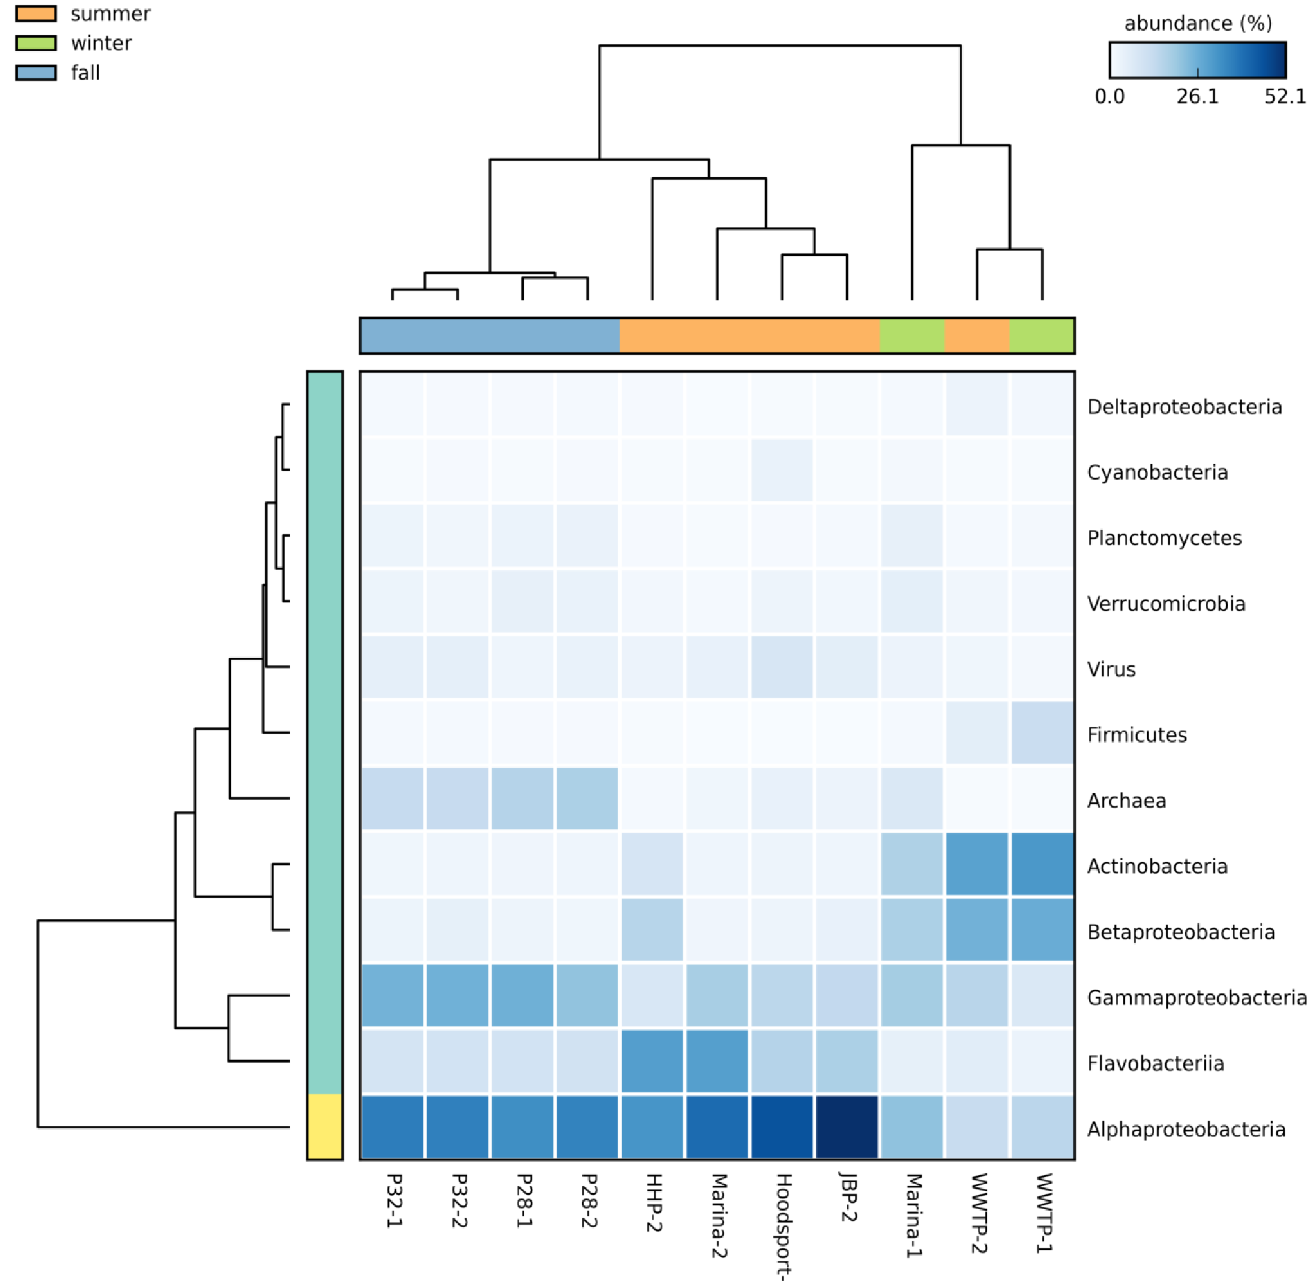
Fig 2. Regional and seasonal community composition differences in Puget Sound showing relative taxonomic abundances for 11 metagenomic samples. Increasing taxonomic abundance is indicated by darker blue boxes. The horizontal color bar at the top reflects season of sample collection. Seattle Shilshole marina nearshore samples (Marina-1 and Marina-2) showed multi-fold seasonal differences between winter and summer measurements in Actinobacteria, Betaproteobacteria, Flavobacteriia and Alphaproteobacteria classes. Archaea were most prominent in offshore P28 and P32 samples and comprised as much as 17% (P28-2) in relative